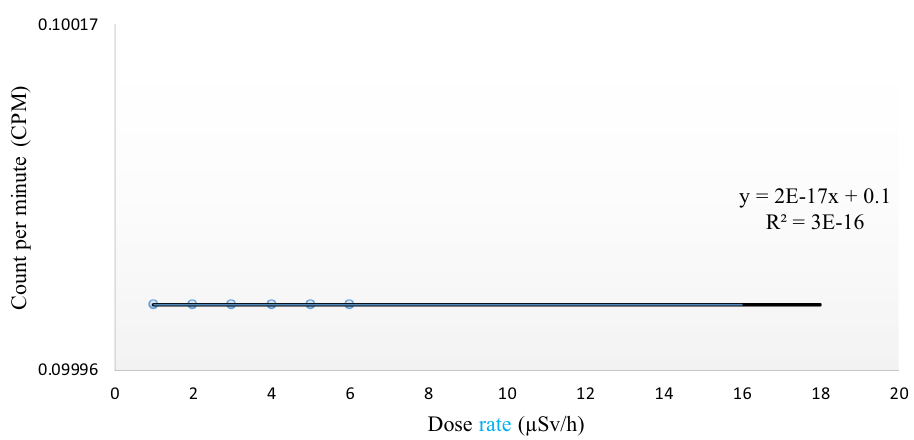
Figure 8. Count per minute (CPM) versus dose rate (µSv/h) measured by the RadioactivityCounter App at Pad